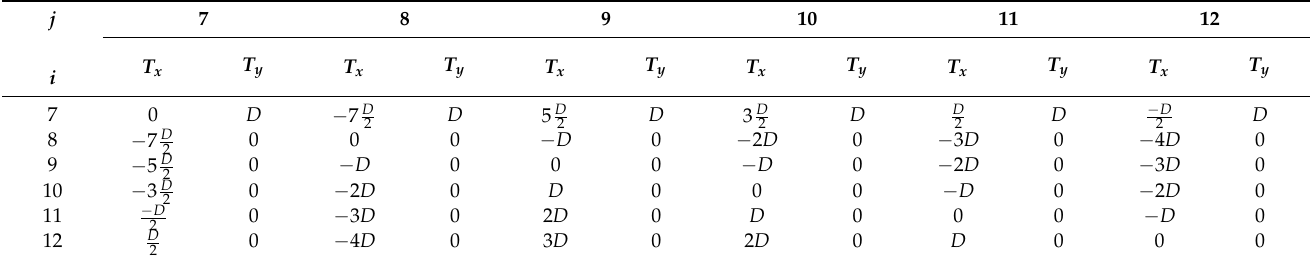
Table 6. Final formation distance in the 12-robot experiment of robots 7–12 for robots 7–12.